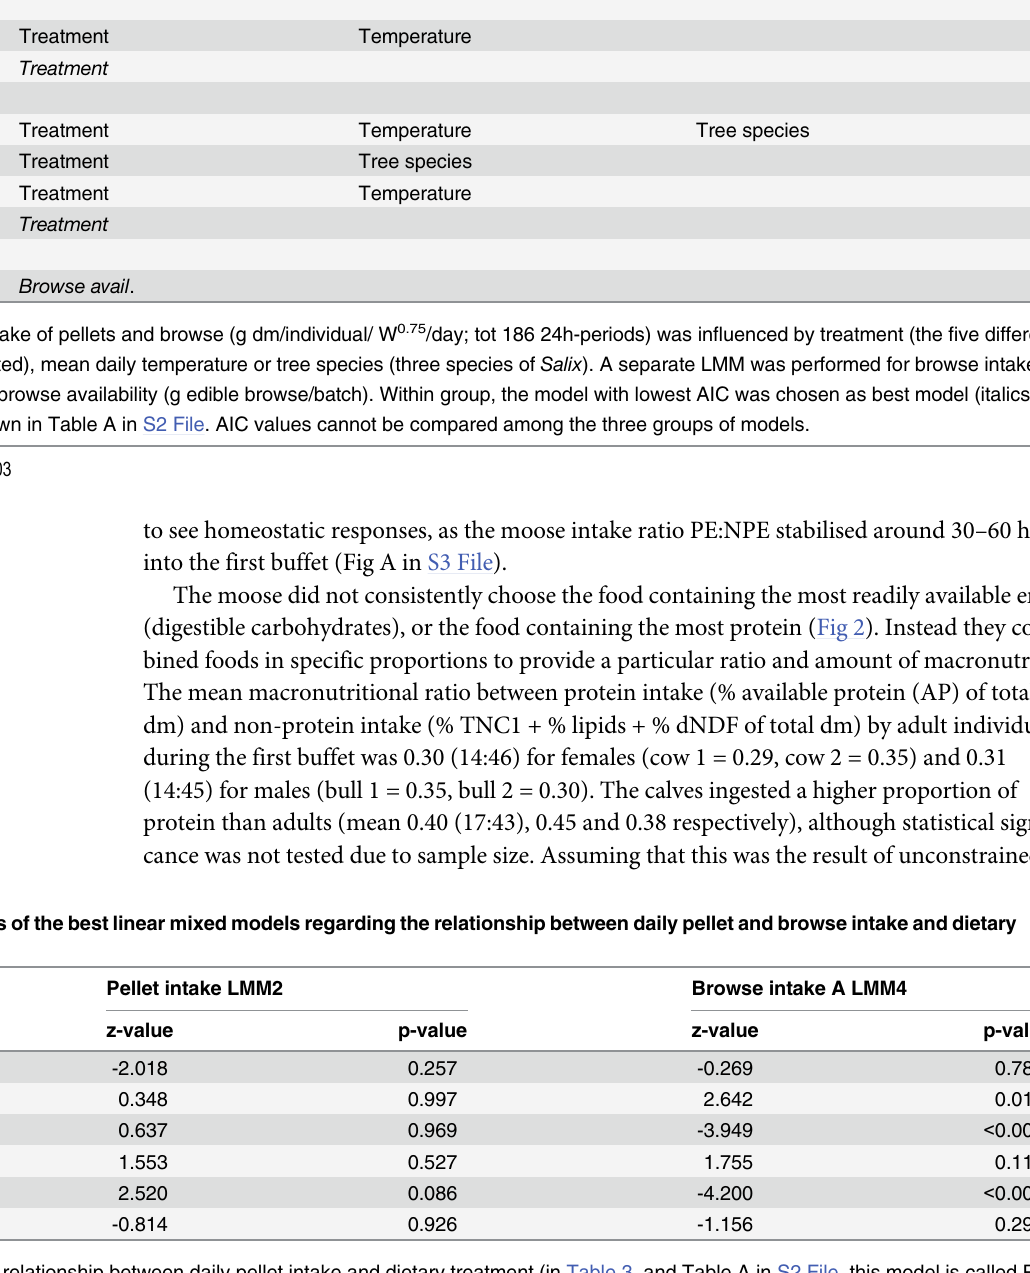
Post-hoc test results show the relationship between daily pellet intake and dietary treatment (in Table 3, and Table A in S2 File, this model is called